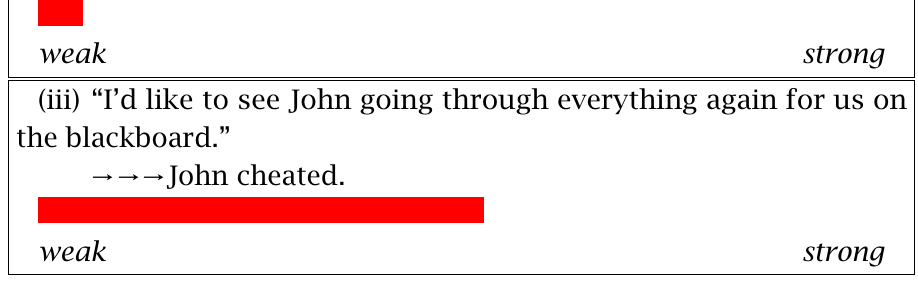
Training example (French version in ( 32 ) in appendix